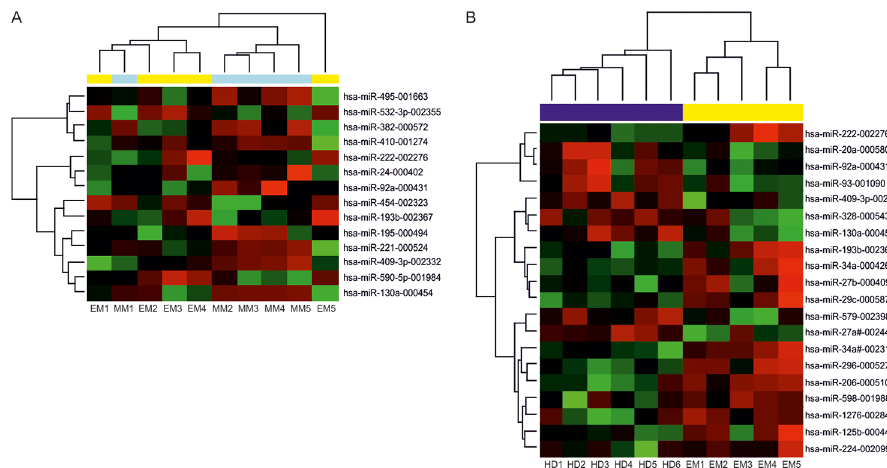
Fig 1. MicroRNA expression pattern in extramedullary myeloma (EM), multiple myeloma (MM) patients and healthy donors (HD). Hierarchical clustergram discriminating EM serum samples from A) MM, yellow color indicates EM serum samples, light blue MM serum samples, p < 0.05. B) HD, yellow color indicates EM serum samples, dark blue indicates HD serum samples, p < 0.05. Differential expression of miRNA is shown by the intensity of red (up-regulation) versus green